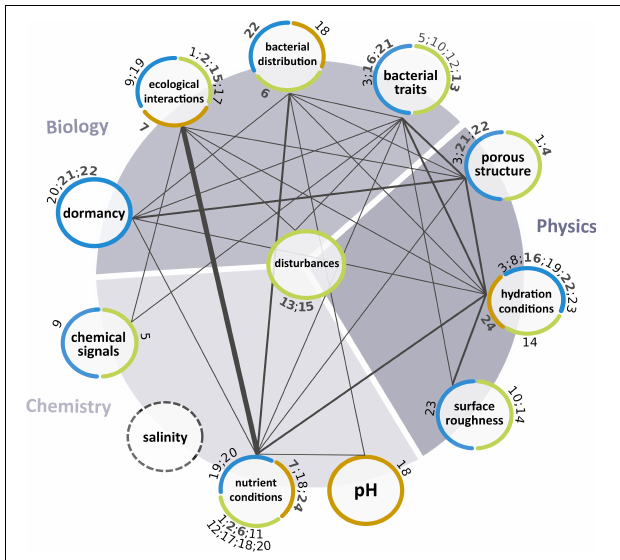
FIGURE 1 | Physical, chemical, and biological aspects (circles) considered in the selected microscale models. The term “ecological interactions” summarizes interactions among bacteria and between bacteria and eukaryotes (e.g., fungi, plants). Color of the outline represents the simulation environment: explicit 2-D or 3-D pore networks (blue), grids (green), or root-shaped areas (orange). Connections indicate the joint consideration of two aspects in a model. Line thickness depicts the number of models considering both aspects ranging from one (1.5 pt), over two (3 pt) to five (7.5 pt). Numbers refer to the respective IBMs (black) or PBMs (gray, bold) in Table 1 . Note that salinity was not considered in the selected